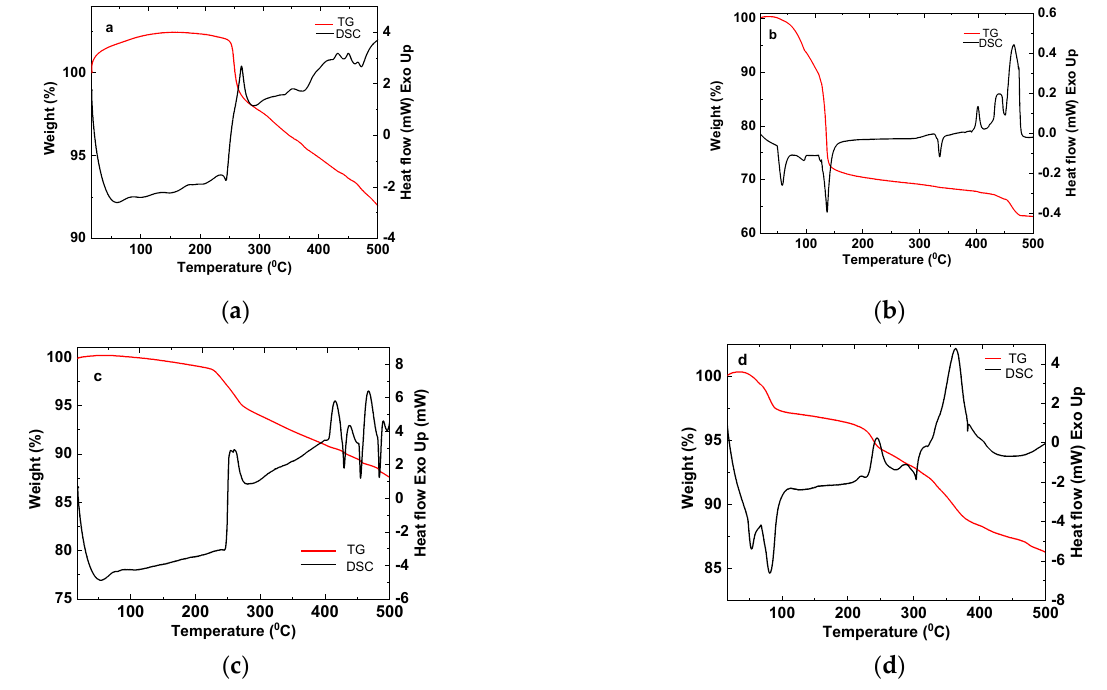
Figure 8. TG-DSC curves of AZA ( a ), Na 2 S 2 O 3 ( b ), AZA after UV exposure ( c ) and the ST-reacted AZA after UV irradiation (AZA:ST 50 wt.%: 50 wt.% sample) ( d ).